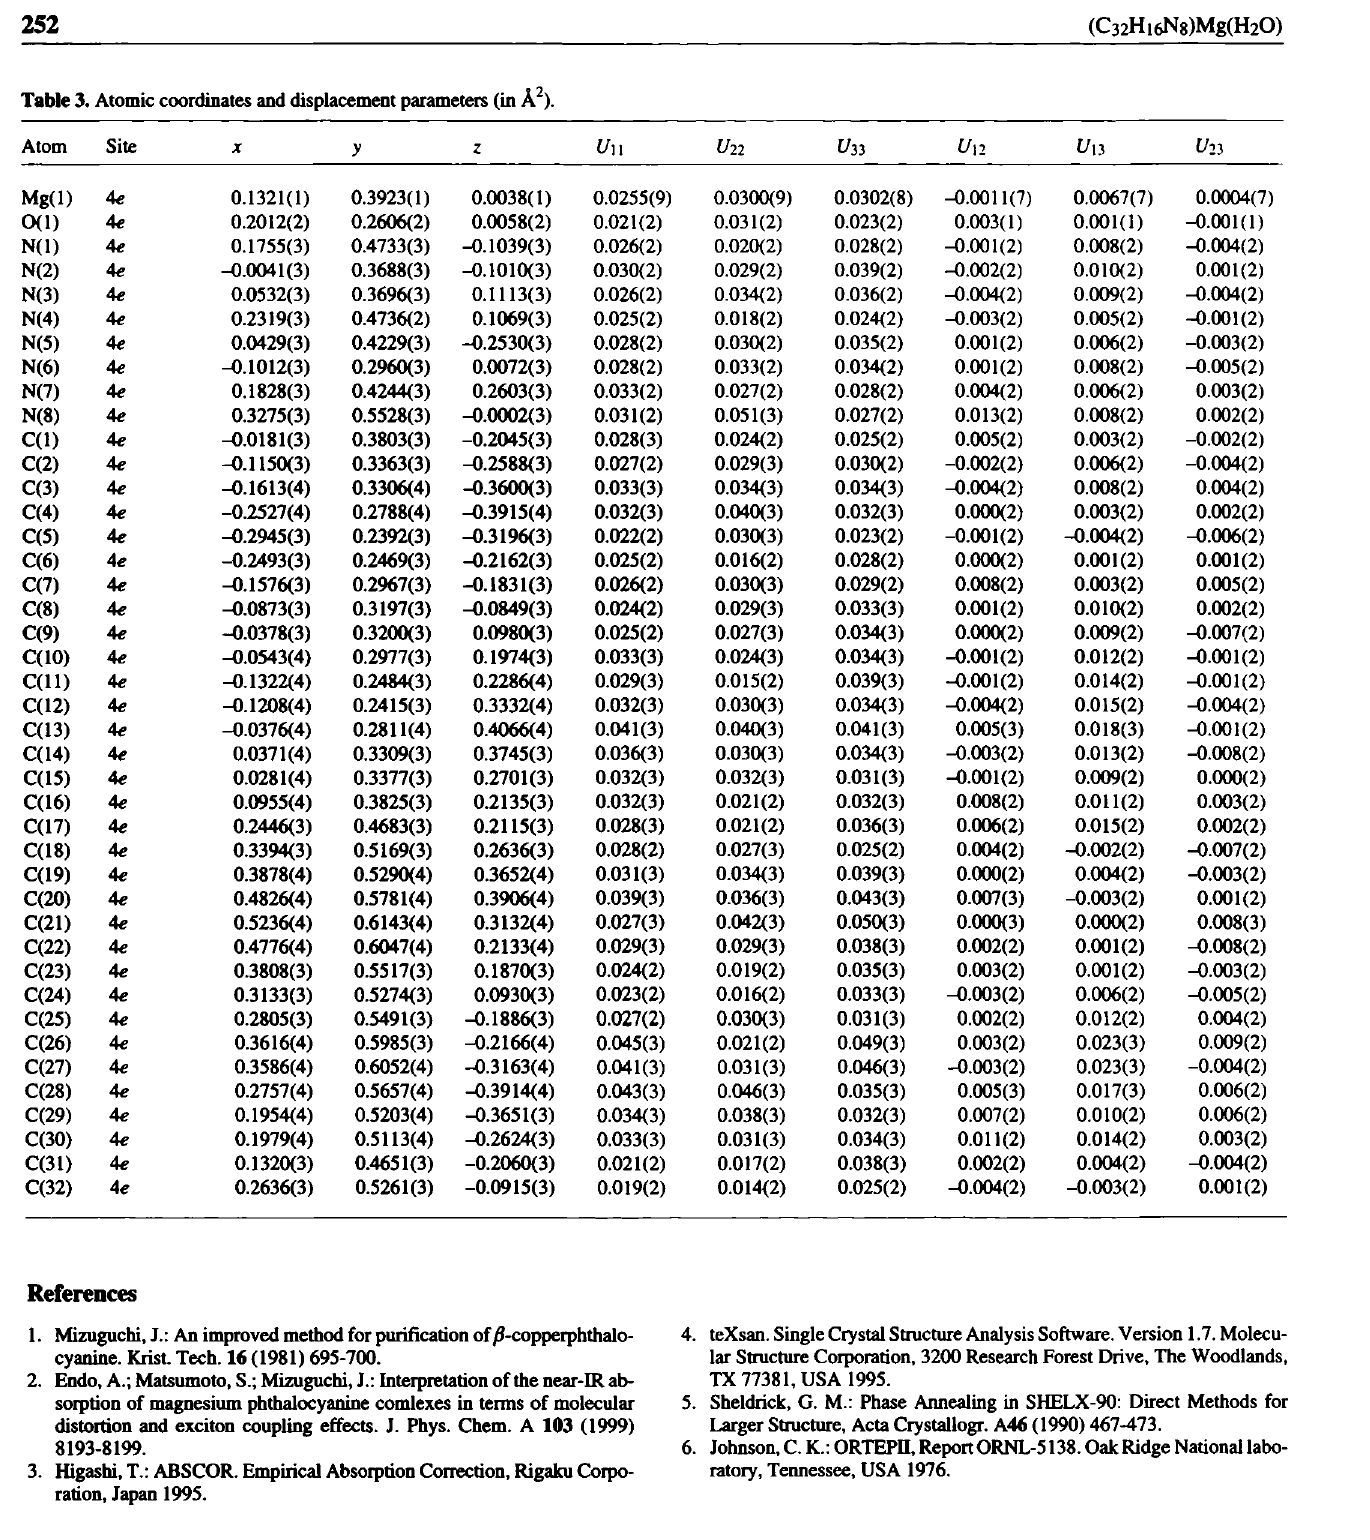
Table 3. Atomic coordinates and displacement parameters (in Â 2